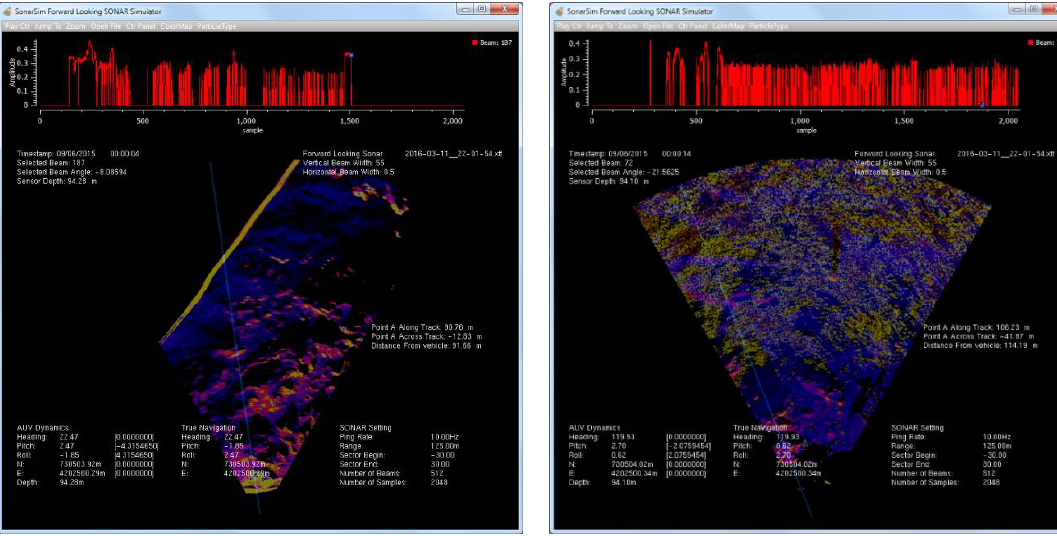
Figure 4. Shallow water forward-looking SONAR imagery. ( Left ) Imaging a port wall and ( right ) noise reverberation from the water surface layer.